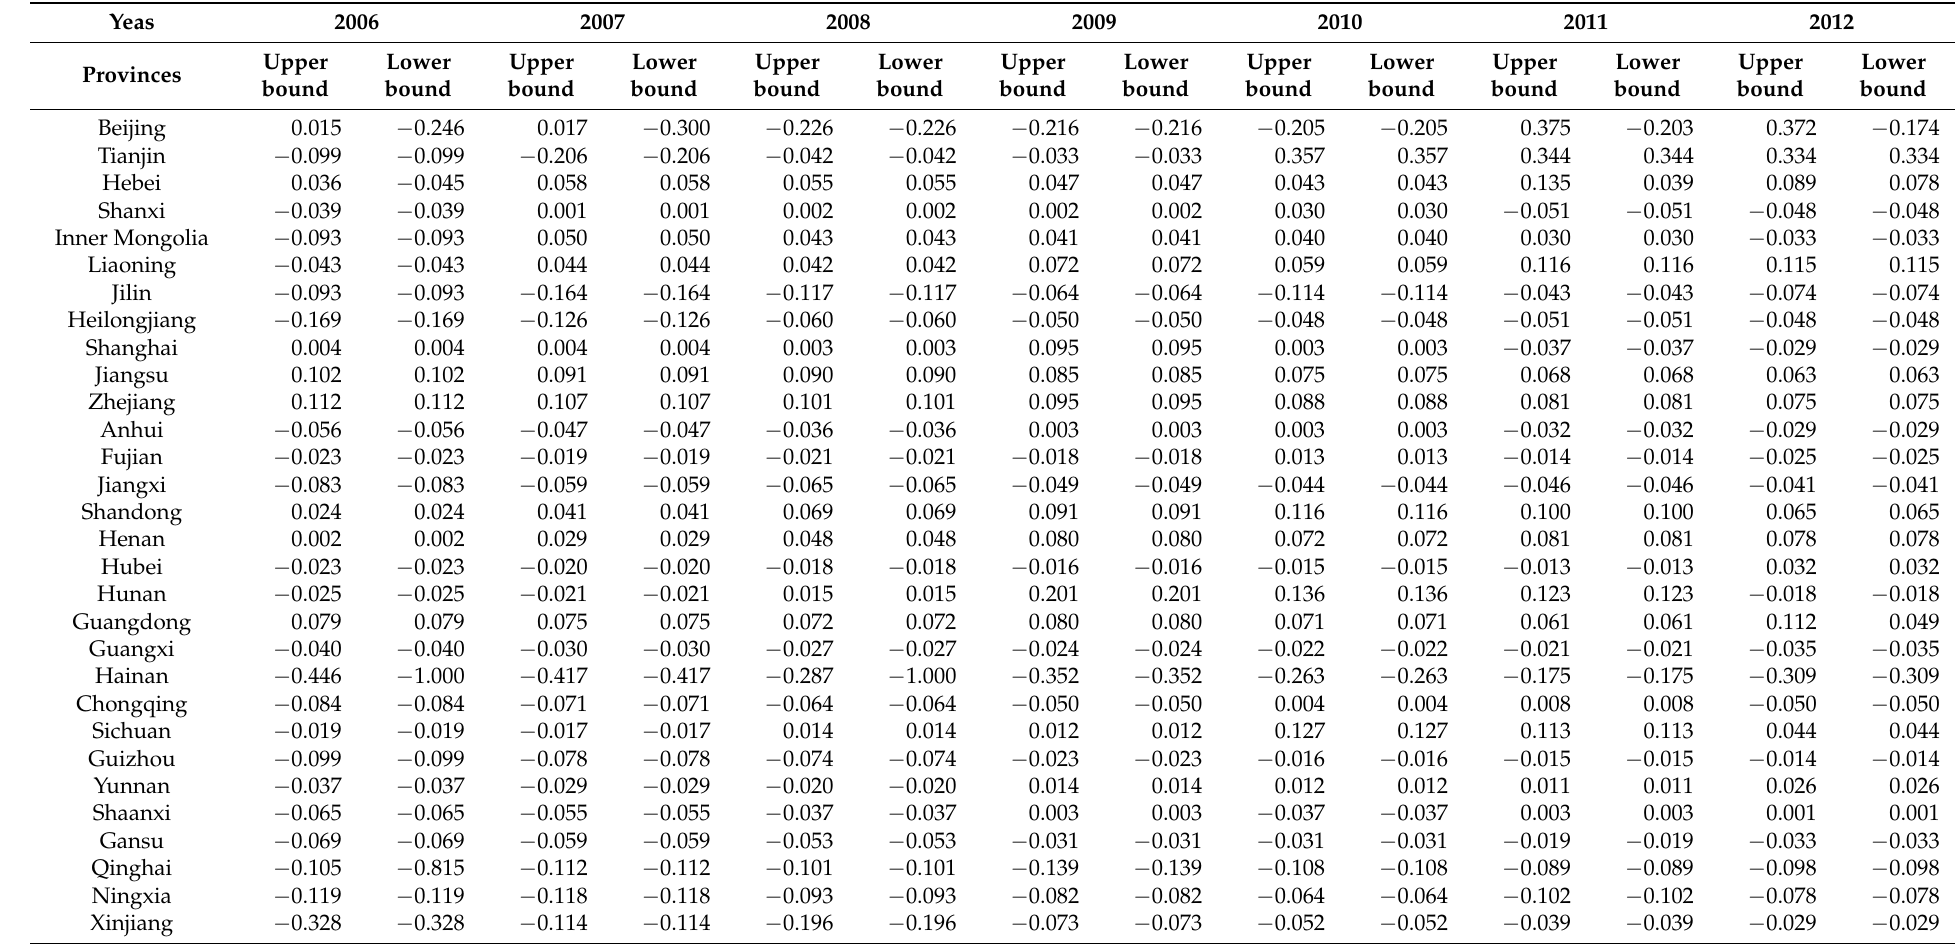
Table 7. The upper bound and lower bound of σ from